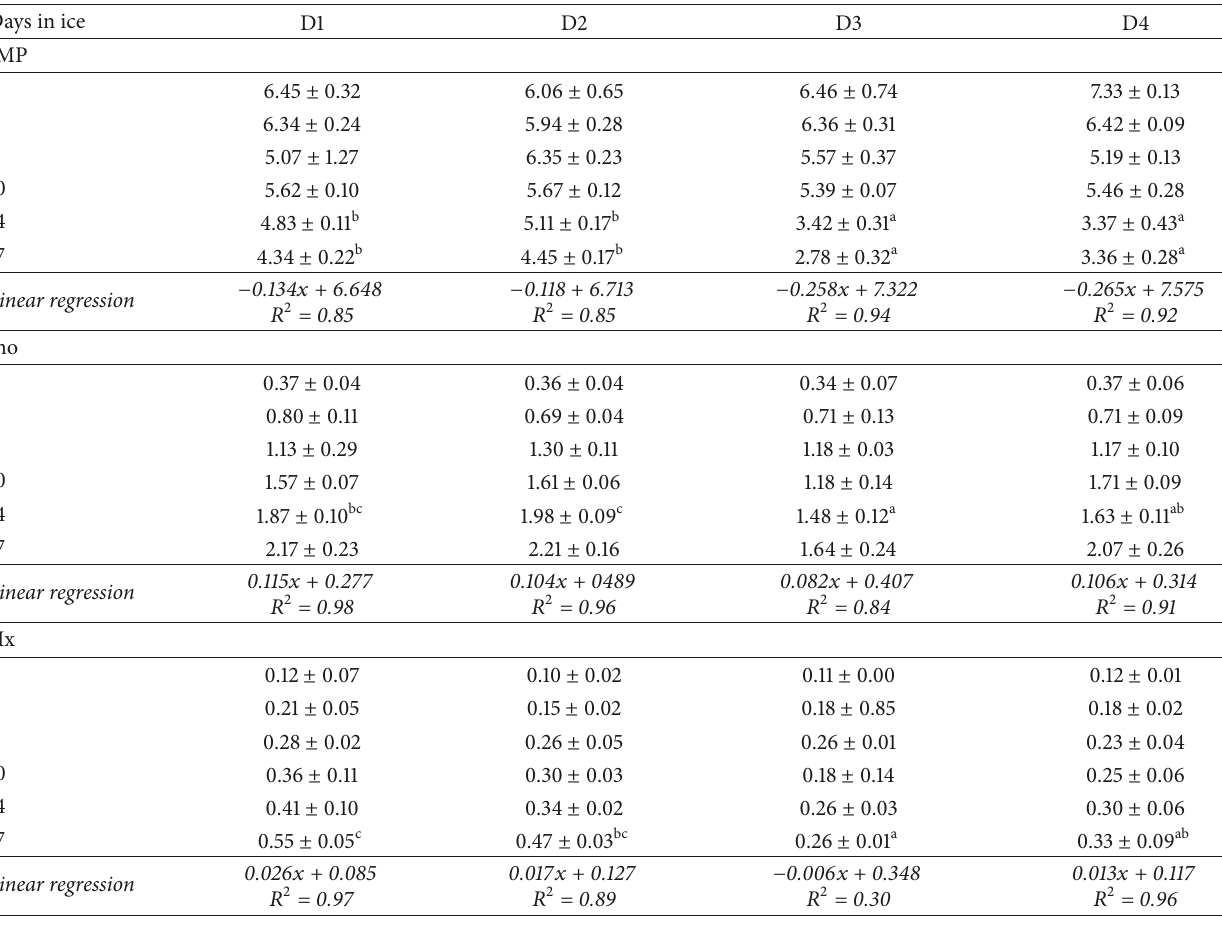
Table 7: Individual ATP breakdown product concentrations in 𝜇 mol g −1 fish fillet in gilthead sea bream fed with the four experimental diets (D1–D4). Data are mean ± SD (𝑛 = 5) . Means not sharing a common superscript letter are significantly different (𝑝 < 0.05) . IMP: inosine monophosphate; Ino: inosine; Hx: hypoxanthine.